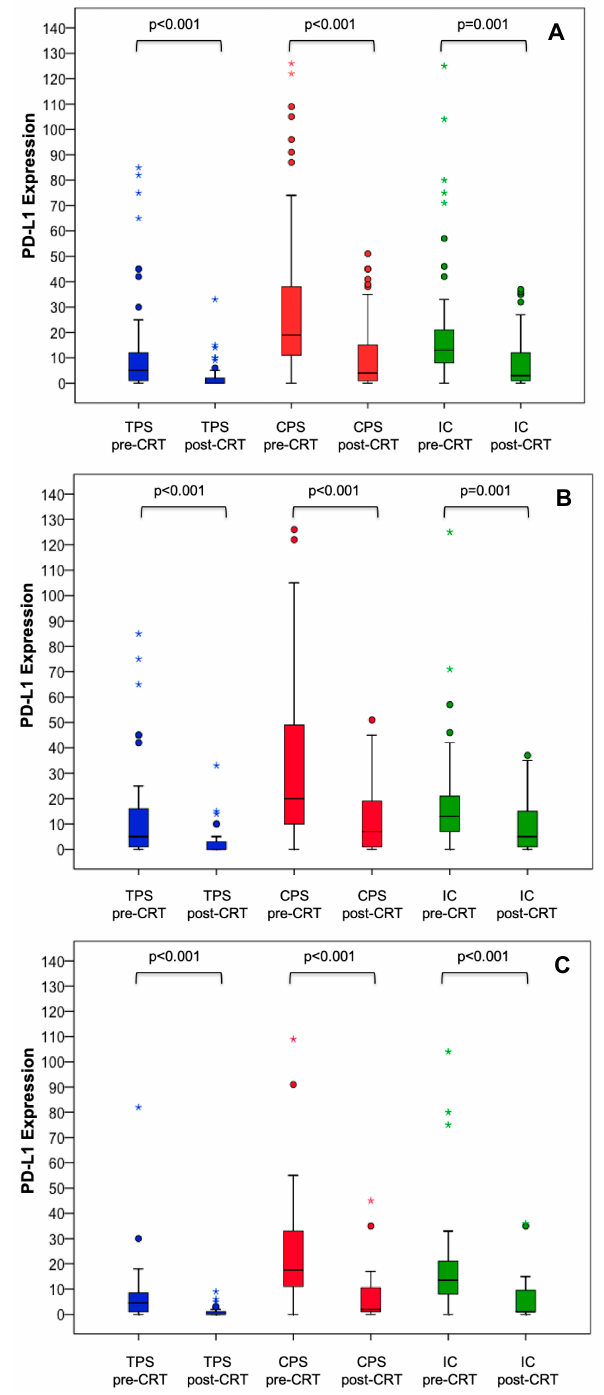
Figure 1. PD-L1 TPS, CPS, and IC changes during neoadjuvant CRT. PD-L1 TPS, CPS and IC changes during neoadjuvant CRT ( A ) in the entire cohort, ( B ) in patients with doublet chemotherapy, and ( C ) in patients with monochemotherapy. CPS: combined positive score; CRT: chemoradiotherapy; IC: immune cell score; PD-L1: programmed death-ligand 1; TPS: tumor proportion score. 3.3. PD-L1 Expression Prior to Neoadjuvant CRT and Association With Surrogate Endpoints